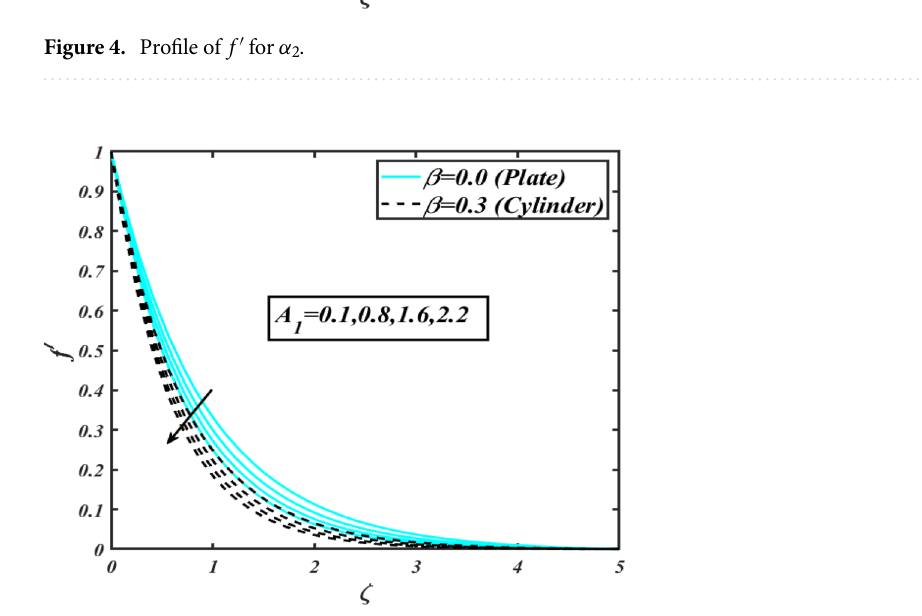
Figure 5. Profile of f ′ for A 1